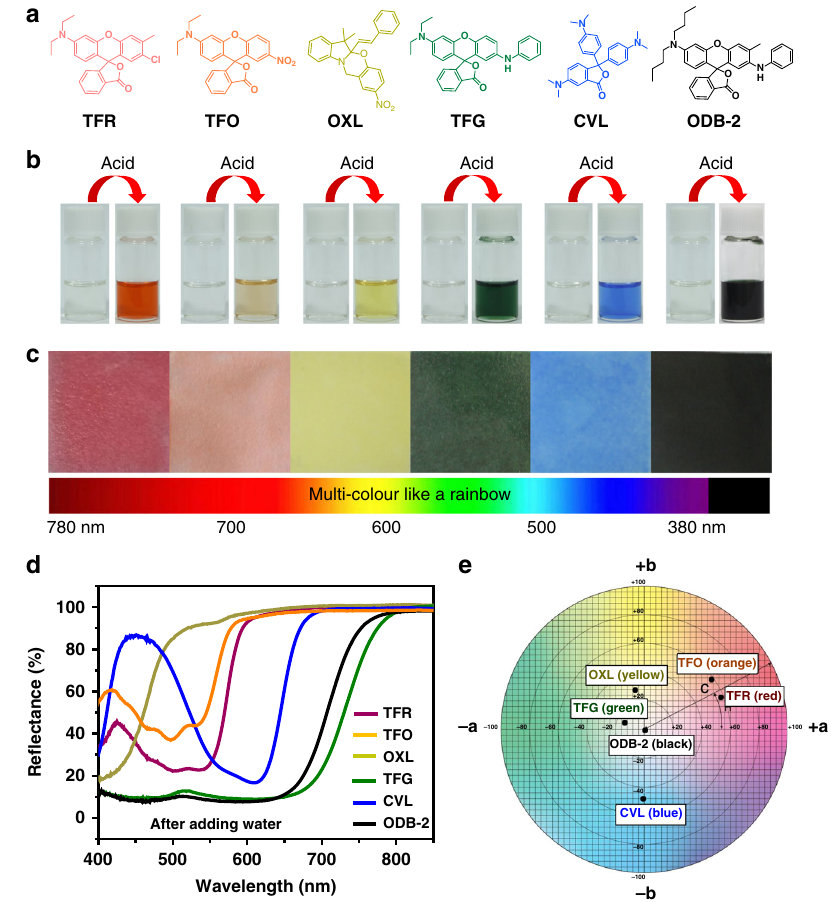
Fig. 5 Other colours for WJRPs based on binary systems. a The structures of a series of acidochromic dyes. b Multicolours obtained by various acidochromic dyes in solution after treating with acid and c on solid state treated with B4H after addition of water and d corresponding UV-vis re fl ection spectra of the solid state. e Plots of corresponding positions of six kinds of WJRPs after adding water in the CIE 1931 colour